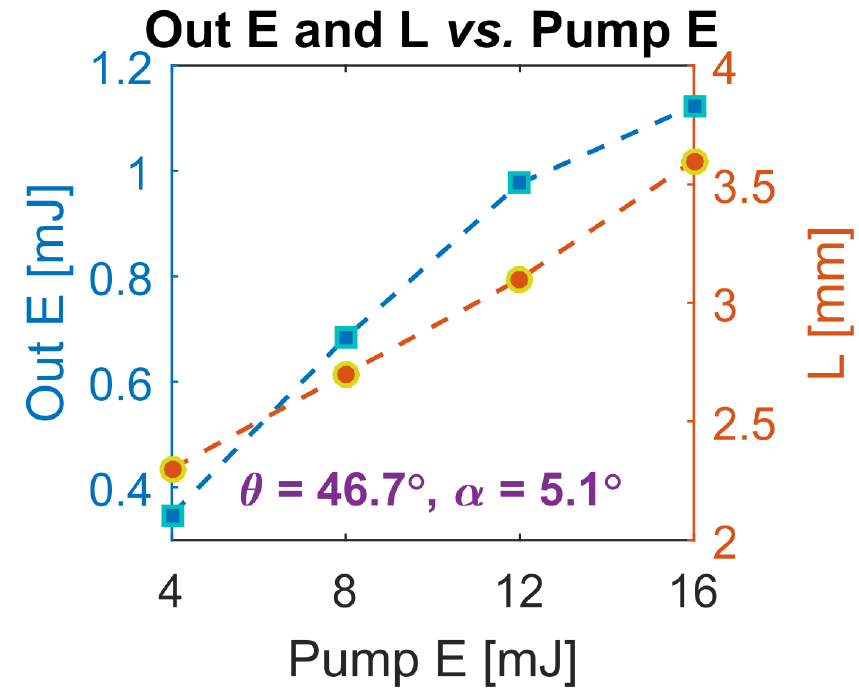
Figure 7. Output energy vs. pump input energy and corresponding crystal length with ouput FTL durations of 50 fs in a single MgO:LN-based amplification